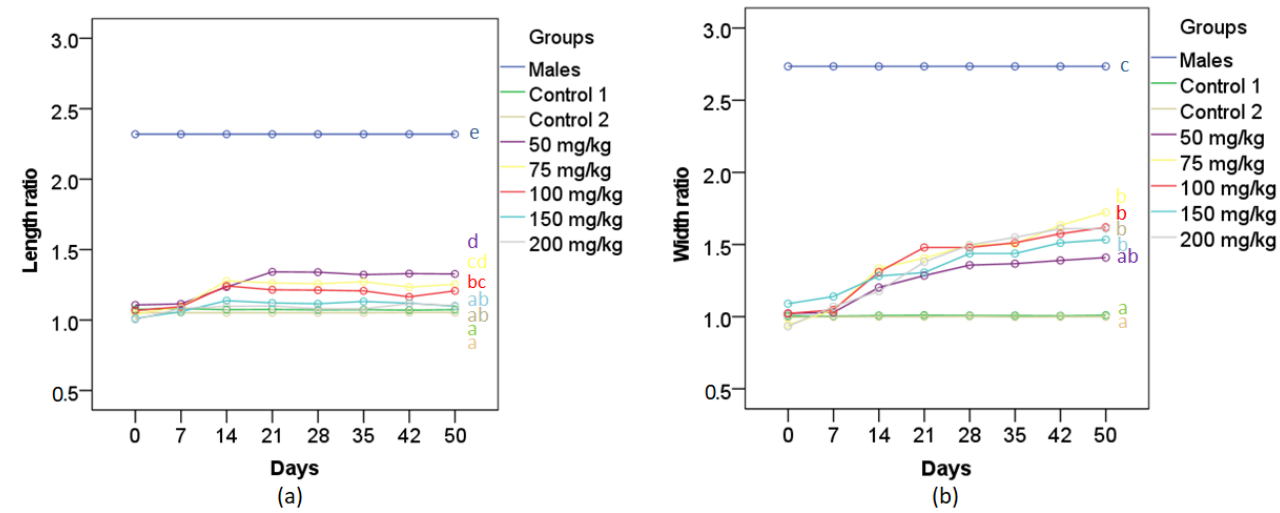
Figure 3. Temporal changes in ( a ) the ratios of the lengths of anal fin rays 4 and 6 and ( b ) the ratios of the widths of anal fins 3 and 4 of RG females treated with different concentrations of MT in their diet ( n = 5). Lines with different letters (color coded to match those of the lines) are significantly different from one another.